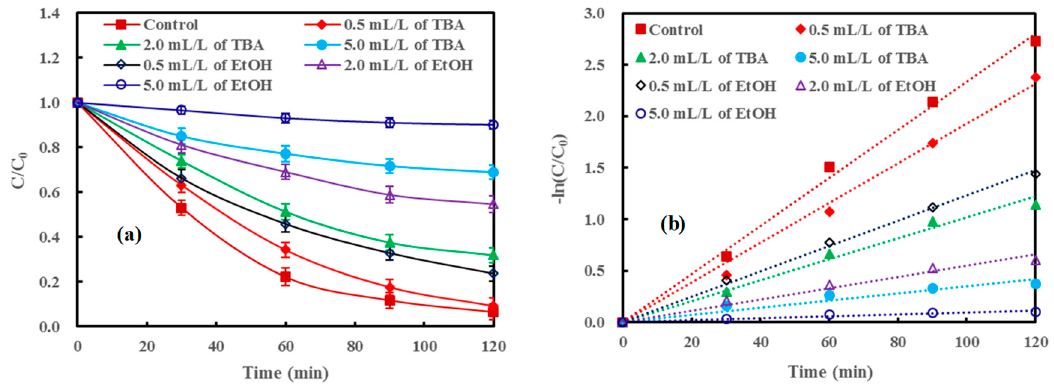
Figure 10. ( a ) Effect of free radical scavengers ( t -butanol, TBA; absolute ethanol, EtOH) on MB removal under visible-light irradiation; and ( b ) pseudo-first-order kinetic fit for MB removal. (Error bars represent standard deviation of triplicate runs).